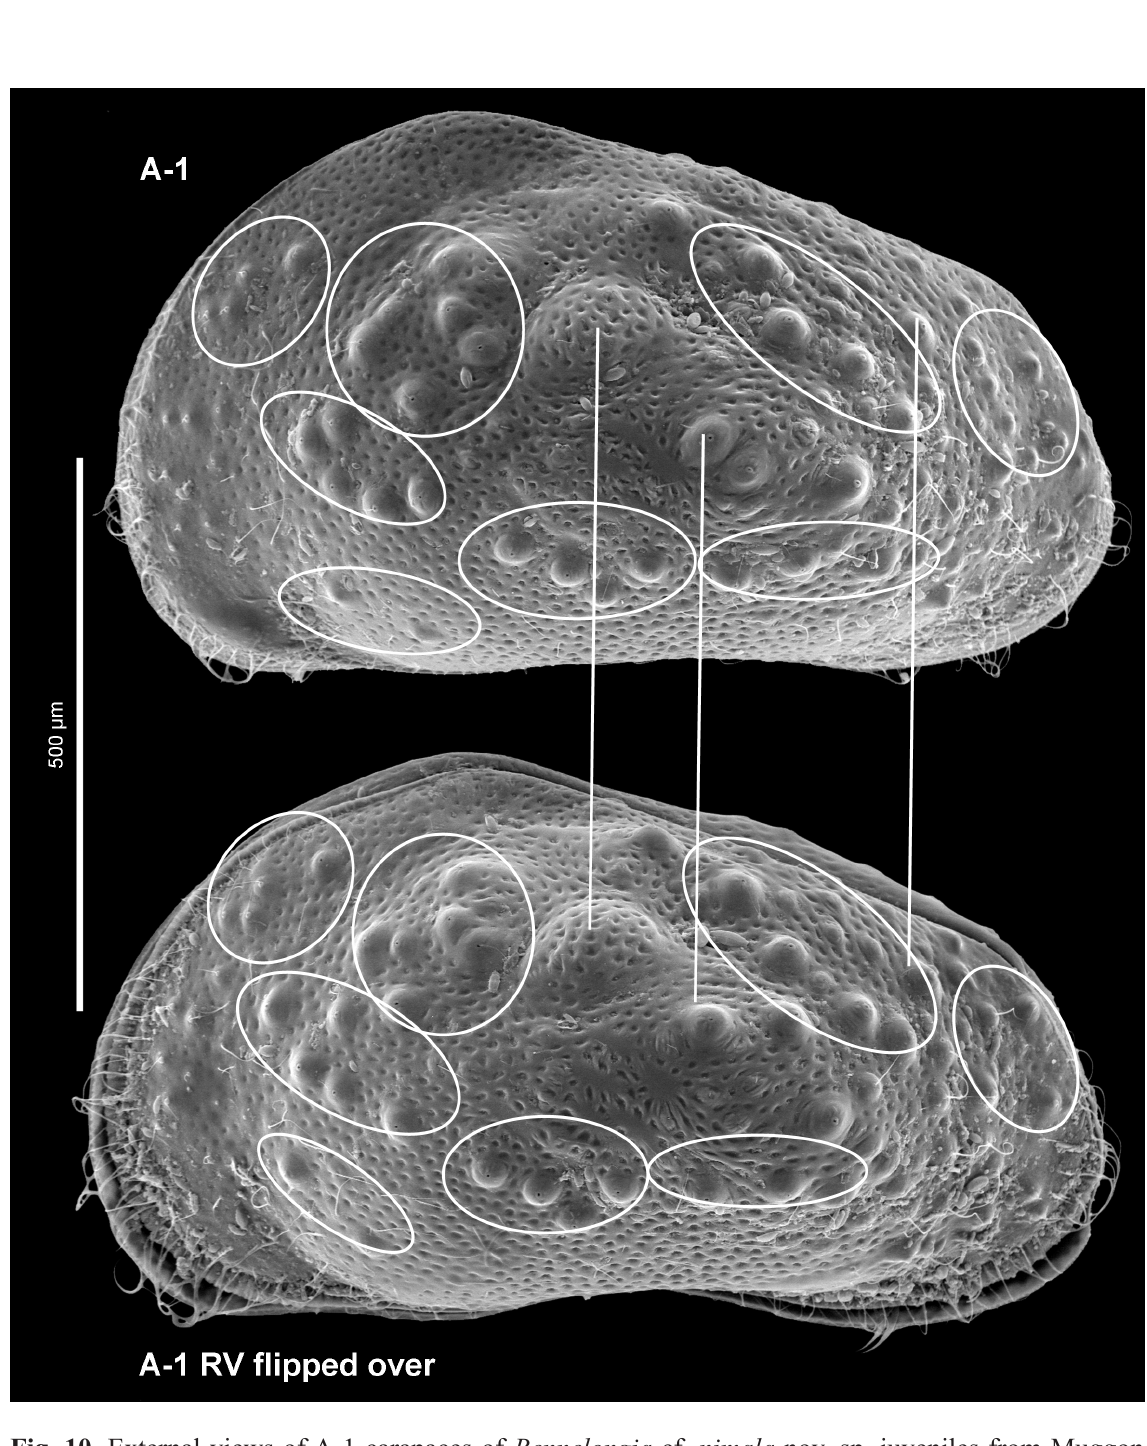
Fig. 10. External views of A-1 carapaces of Bennelongia cf. nimala nov. sp. juveniles from Muggon Lake. The top image shows an A-1 LV, whereas the bottom image shows a RV of an A-1 specimen that has been ‘flipped over’ digitally so as to permit comparison of the type of external ornamentation and respective location. Same comments as for Figure 9 concerning the white